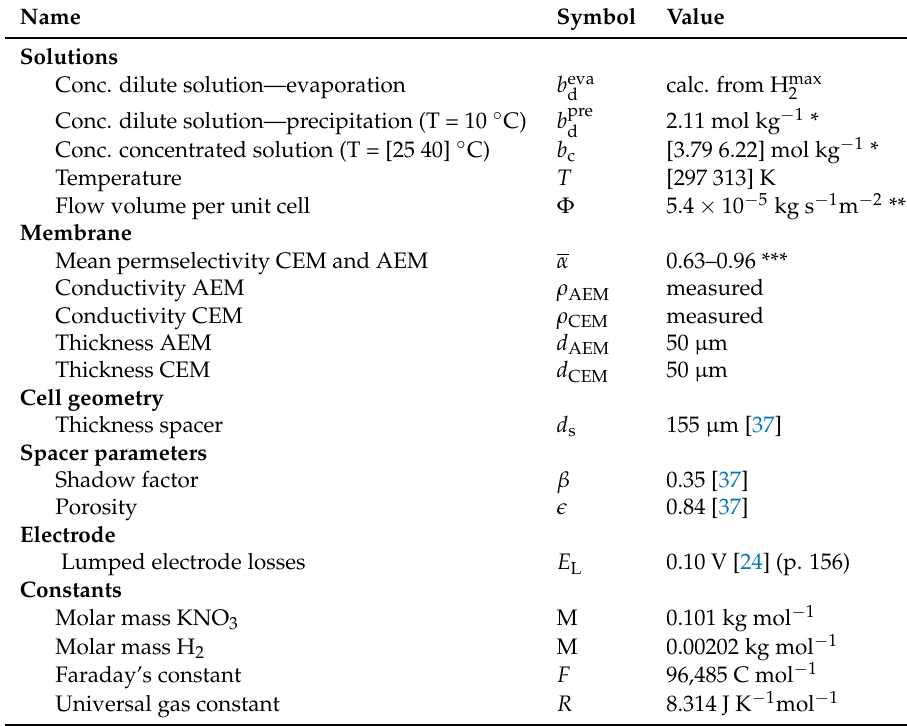
Table 4. Input values used to model power density and hydrogen production from